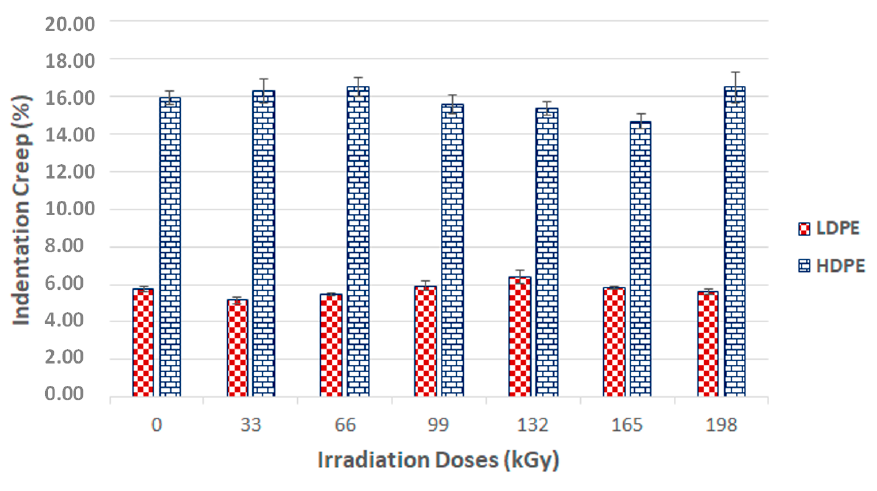
Figure 10. Indentation creep ( C IT ) of irradiated LDPE and HDPE; the vertical line drawn at the top of the column represents the standard deviation.